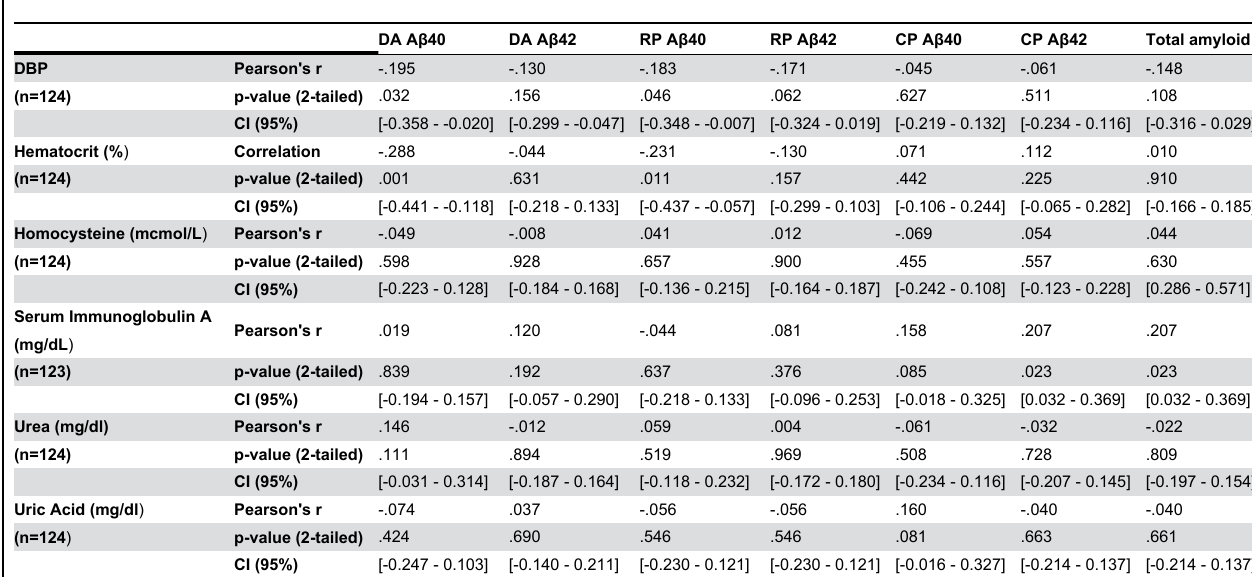
Table 3. Partial correlations between Aβ measurements and clinical parameters observed in this study adjusted by Age, creatinine, gender and